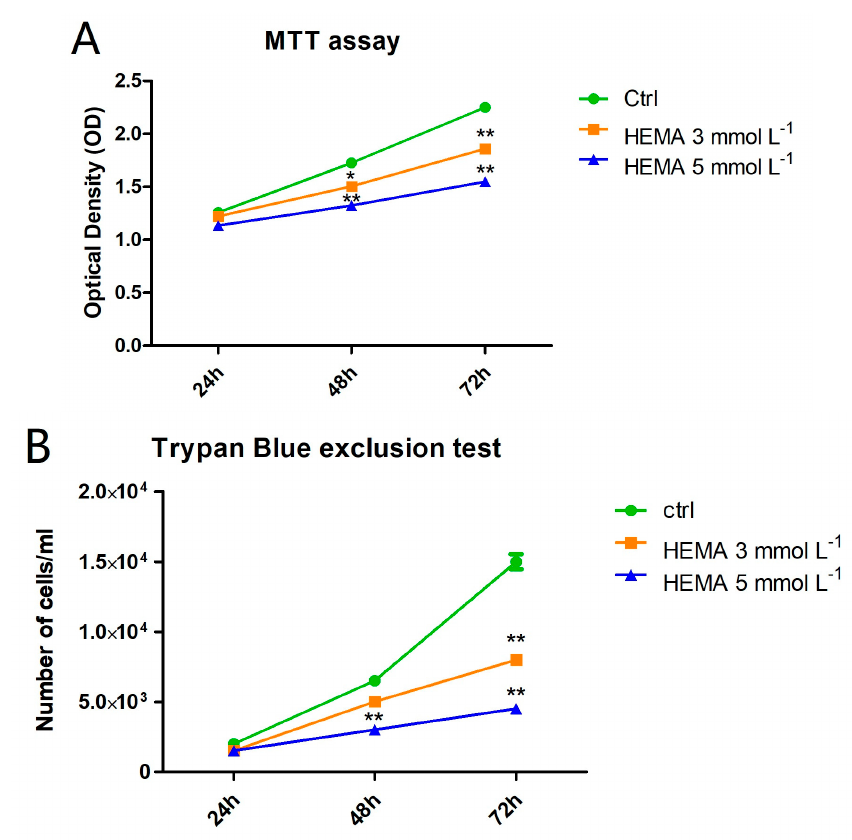
Figure 3. Cell viability and proliferation. ( A ) The results of MTT assay in untreated hDPSCs and in hDPSCs treated with HEMA 3 mmol L − 1 and HEMA 5 mmol L − 1 . ( B ) The results of Trypan Blue